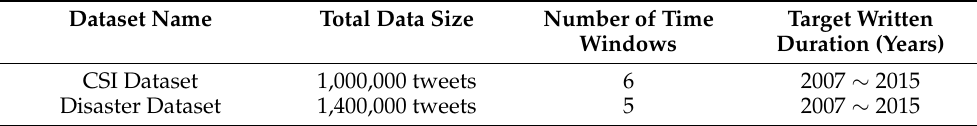
Table 3. The used twitter